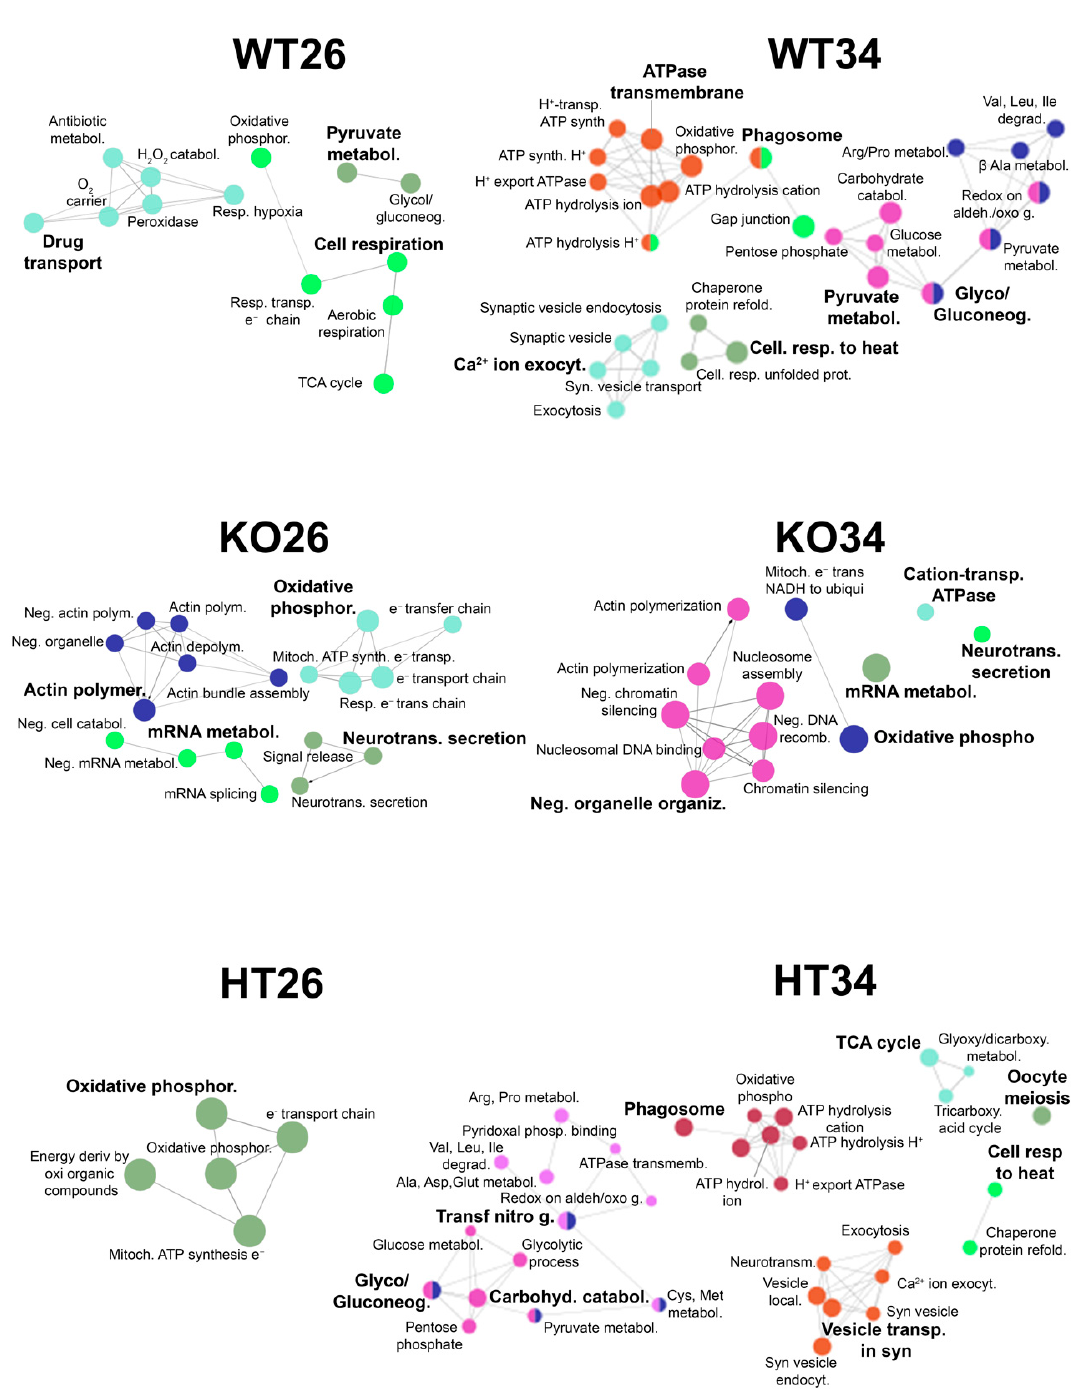
Figure 7. Functional analysis by ClueGo of the proteins most differentiated comparing each data set (WT26, WT34, KO26, KO34, HT26, HT34) with all the others. All data sets were analysed using R-Bioconductor: LFQ data were normalised to the median and analysed for differential expression by the limma package, choosing |Log2FC| > 0.585 and FDR < 0.05 as differential thresholds for the limma test. Each data set was compared with all the others, and the proteins most differentiated were analysed by ClueGo. Functional grouping was based on Fischer’s exact test p ≤ 0.05.